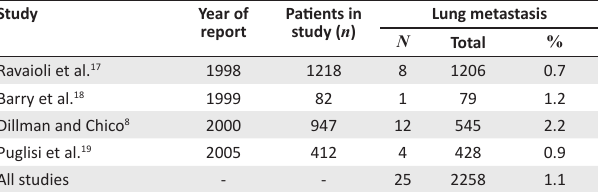
TABLE 1: Prevalence of lung metastasis in all stages of disease as detected by chest